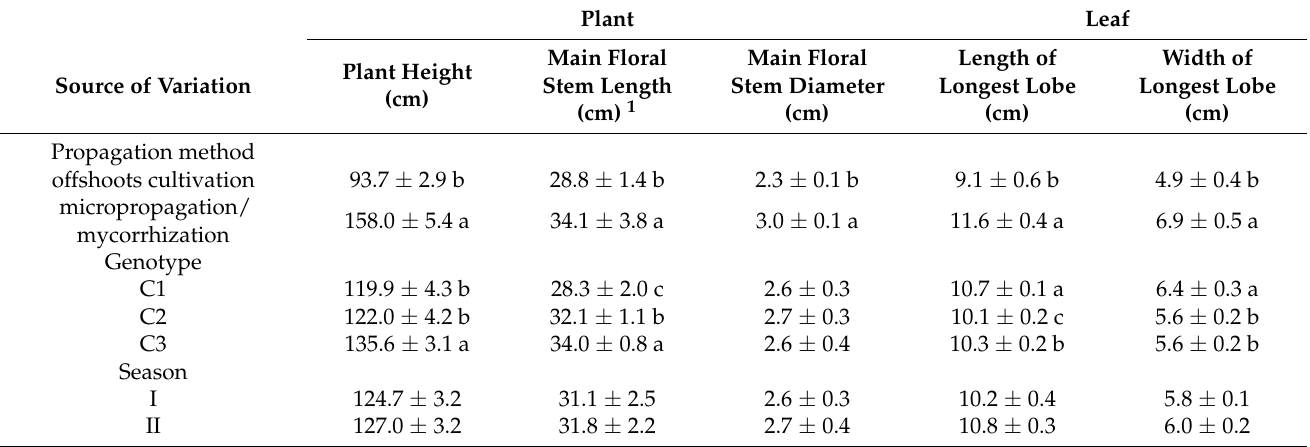
Table 2. Morphological characterization of the selected globe artichoke genotypes ( ± standard deviation) as affected by main factors under study. Different letters within the same parameter and main factor show significant differences among means (LSD test, p < 0.05).